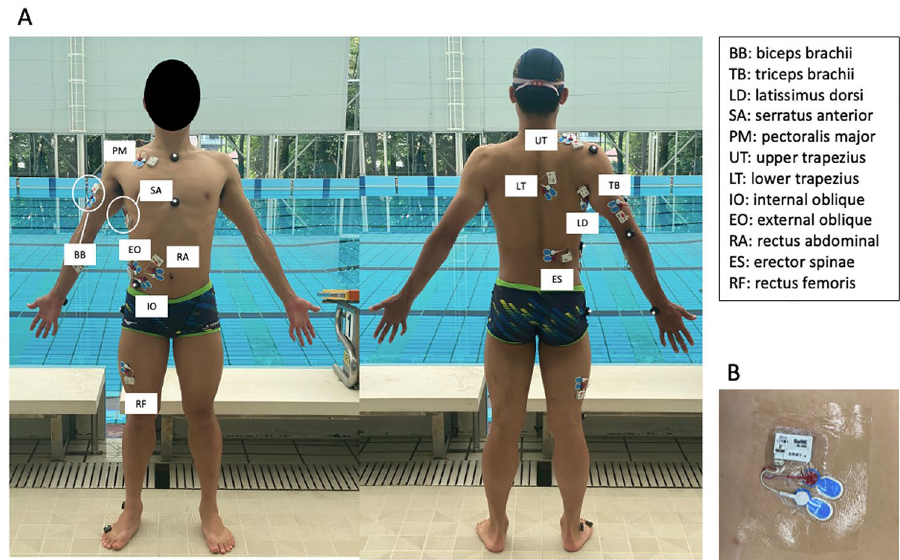
Figure 1. ( A ) Electrode placement. ( B ) The waterproof electrodes were covered with waterproof adhesive sheets to prevent water immersion.